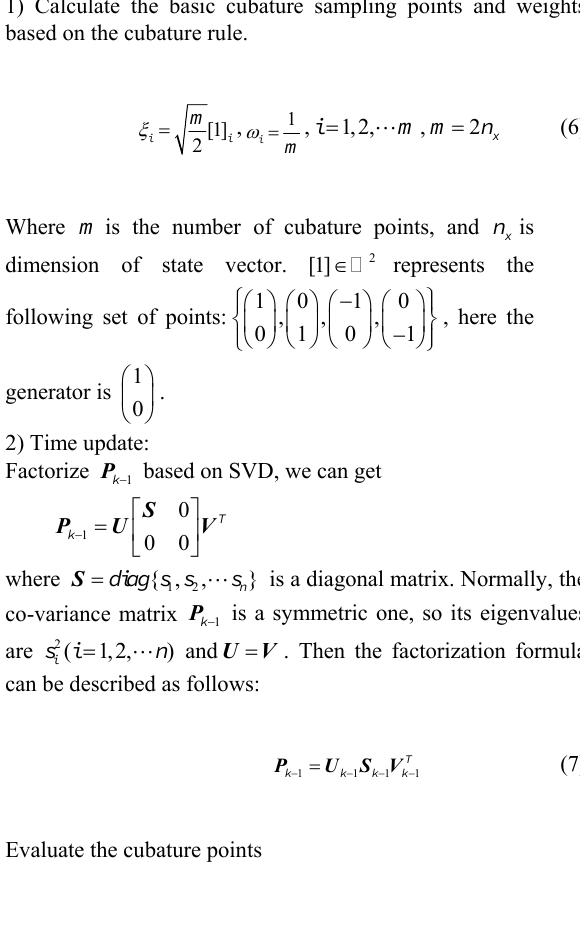
are known nonlinear functions; and are the independent process and measurement Gaussian noise sequences with zero means and covariance